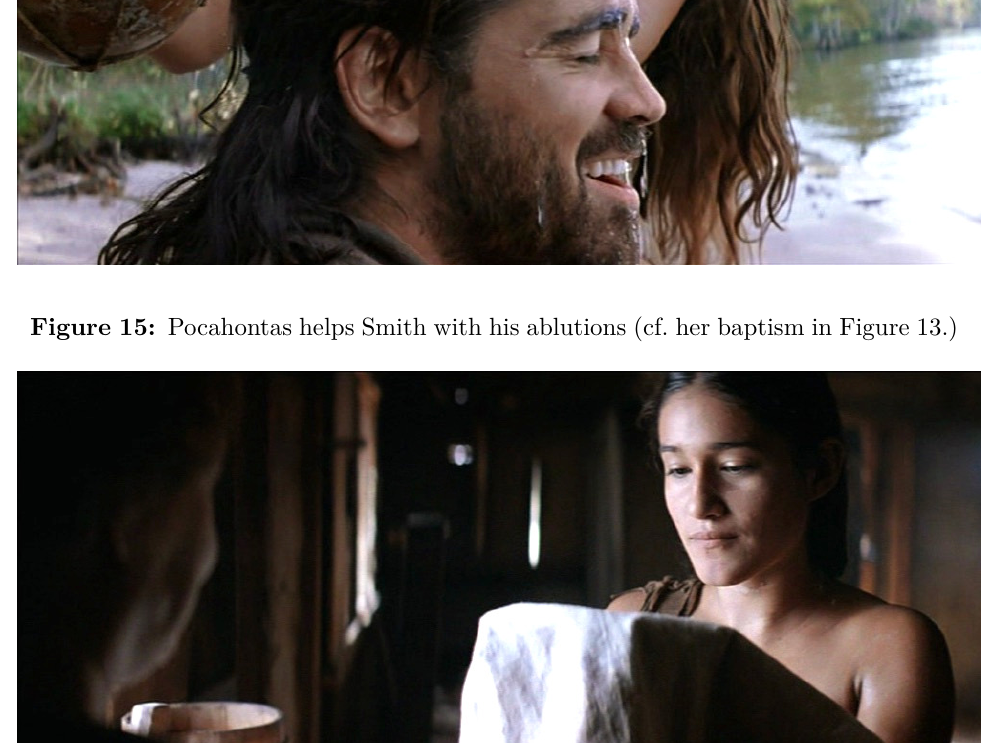
Figure 16: Pocahontas at her own ablutions, Jamestown-style.